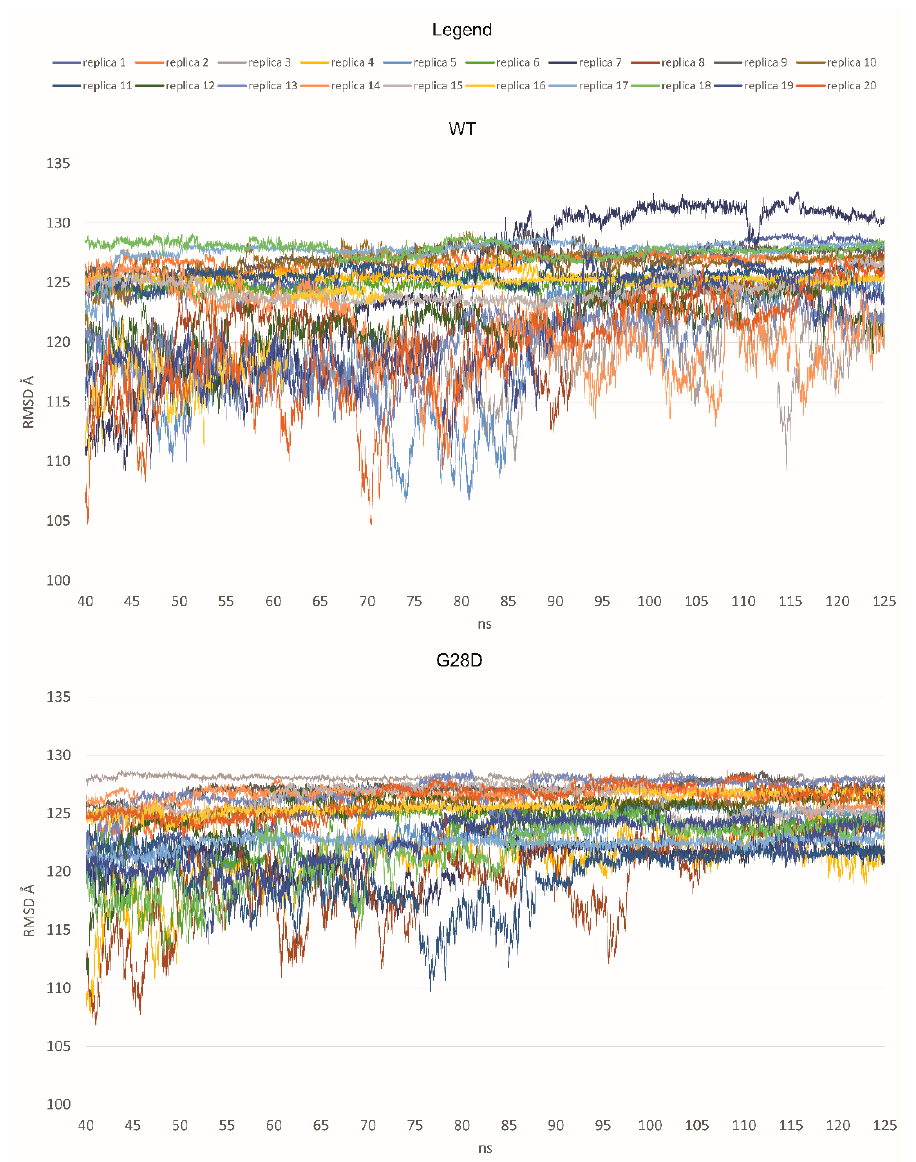
Figure 3. RMSD values for each replica of the WT and the G28D of NUP98 FG domain. In the plot, the RMSD values are shown from 40 nanoseconds (ns) of simulation to make the observation of the stable replicas easier.